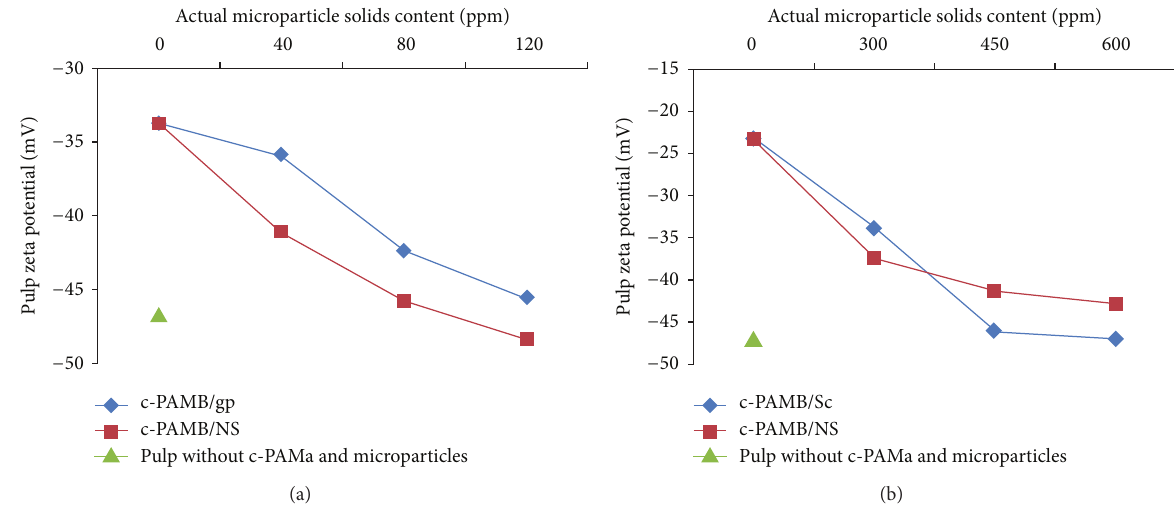
Figure 1: Effects of adding different doses of microparticles on the pulp zeta potentials in (a) c-PAMa and (b) cPAMb systems.